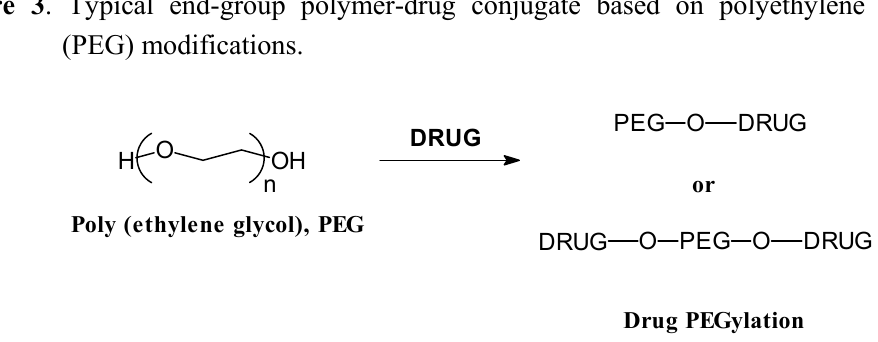
Figure 3 . Typical end-group polymer-drug conjugate based on polyethylene glycol (PEG) modifications.